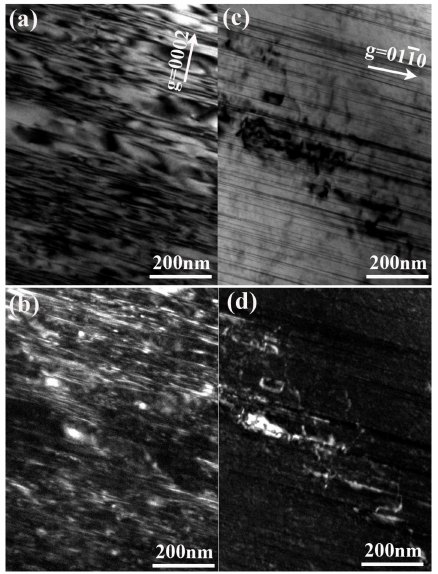
Figure 6. TEM image near the tensile fractured area for 200-h aged alloy: ( a ) bright field(BF) image and ( b ) dark field (DF)image using g = 0002; ( c ) BF image and ( d ) DF image using g =